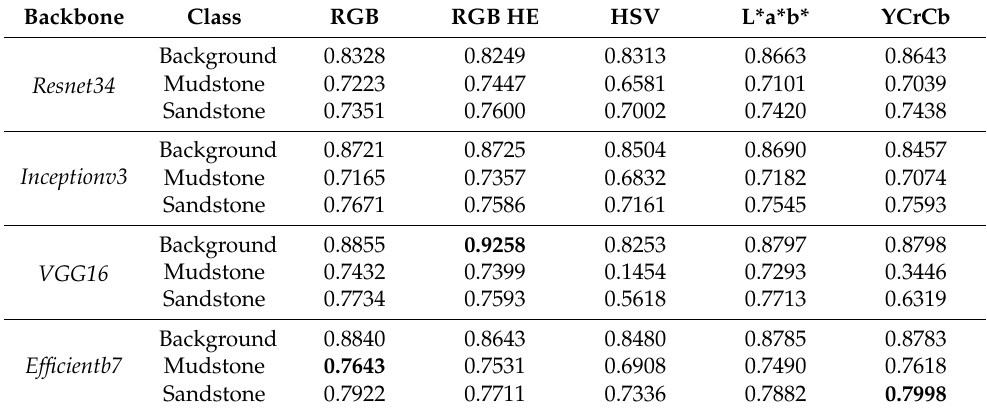
Table 5. Performance evaluation (IoU) of LinkNet models for individual classes in test sets using different image color representations. The best model performance for each class is presented in